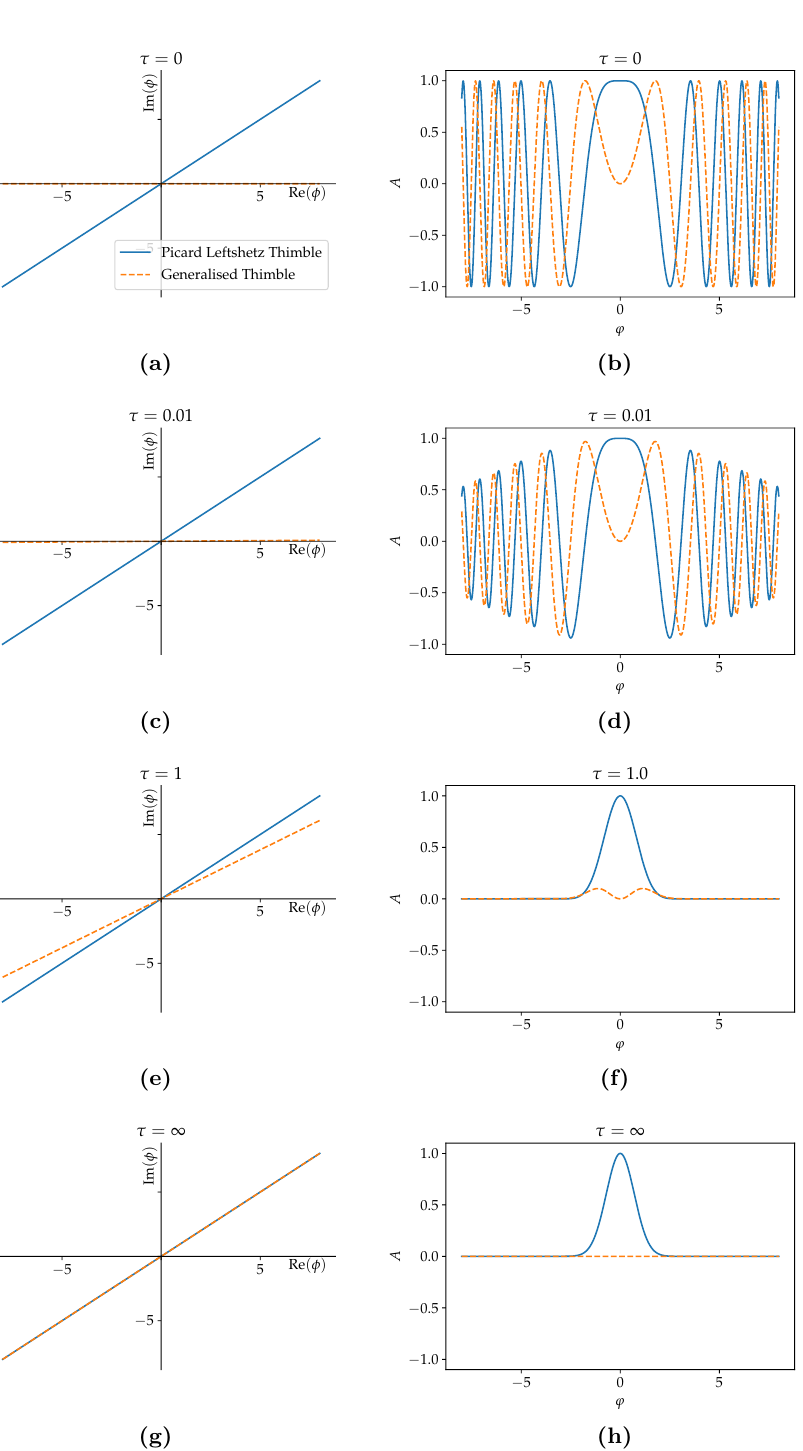
iφ 2 , for a number of different flow times τ . 2